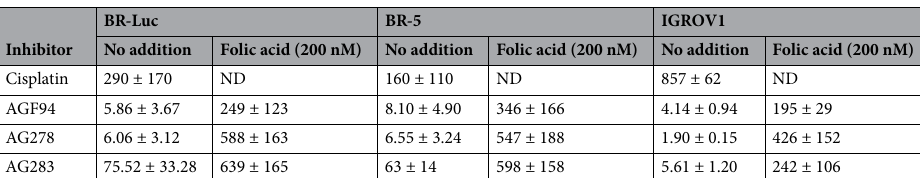
Table 1. IC 50 values (in nM) for anti-proliferative activities of novel compounds on HGSOC mouse models BR-Luc and BR-5 compared to cisplatin. In vitro proliferation assays were performed for BR-5 and BR-Luc mouse HGSOC tumor cells (both express RFC, FRα, and PCFT). Anti-proliferative studies were performed in folate-free RPMI1640 media with 10% dialyzed FBS and 25 nM leucovorin. To measure FR-mediated drug delivery, experiments were performed in the presence or absence of 200 nM folic acid. Results are presented as IC 50 values, corresponding to the concentrations that inhibit growth by 50% relative to cells incubated without drug. The data are presented as mean values from at least 3 experiments (± standard errors). The pyrrolo[2,3- d ] pyrimidine antifolates were previously described 21,22 . ND not